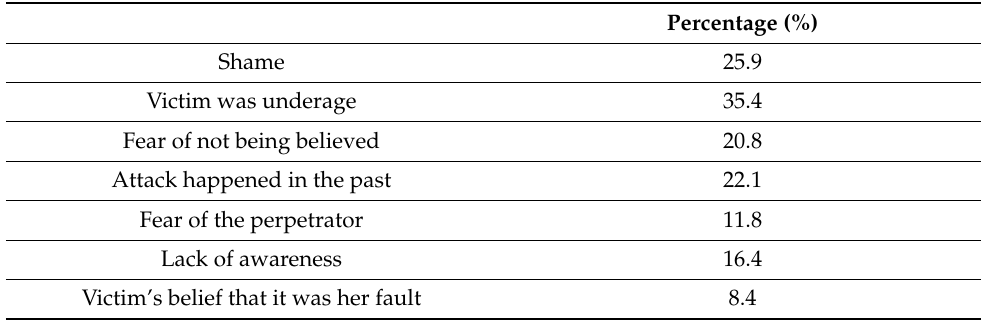
Table 5. Motives for not reporting sexual violence, according to women who have experienced this kind of violence outside a couple relationship